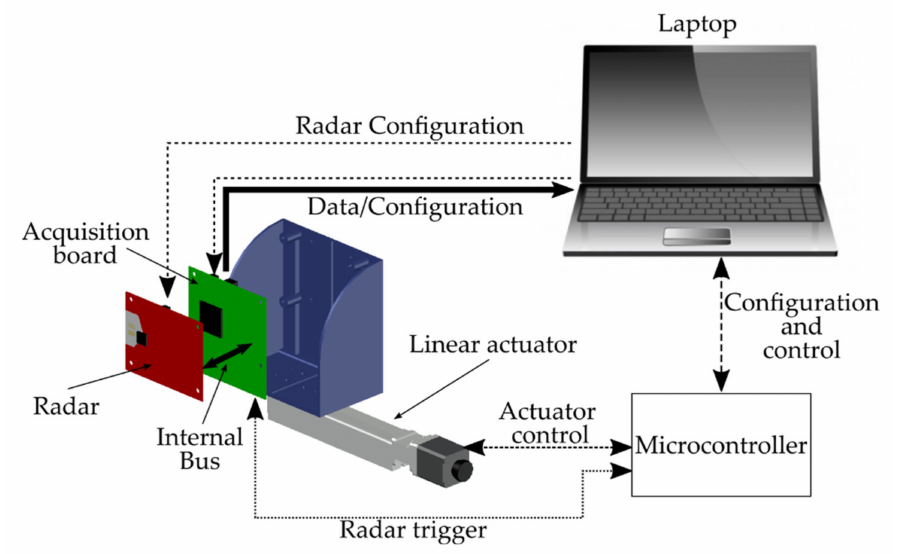
Figure 1. Scheme of proposed